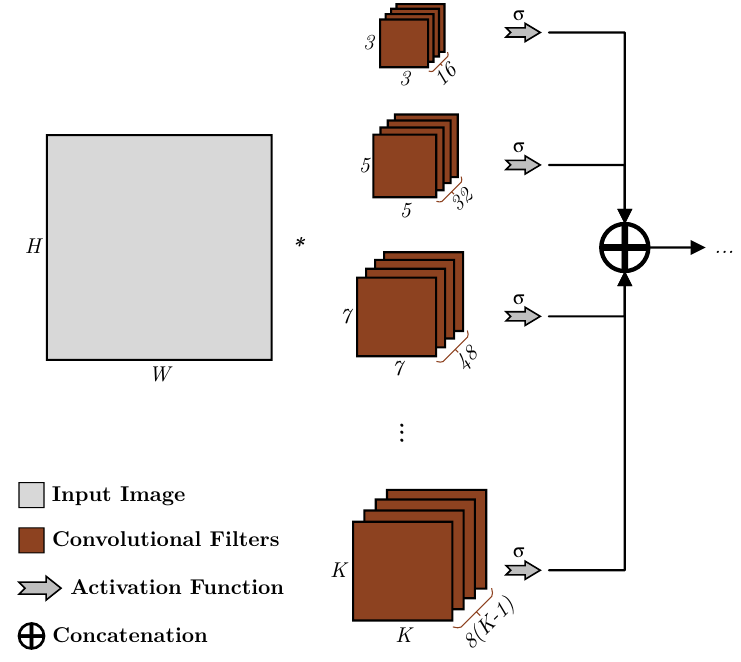
Figure 8. An overview of the Adaptive Kernels Layer using c